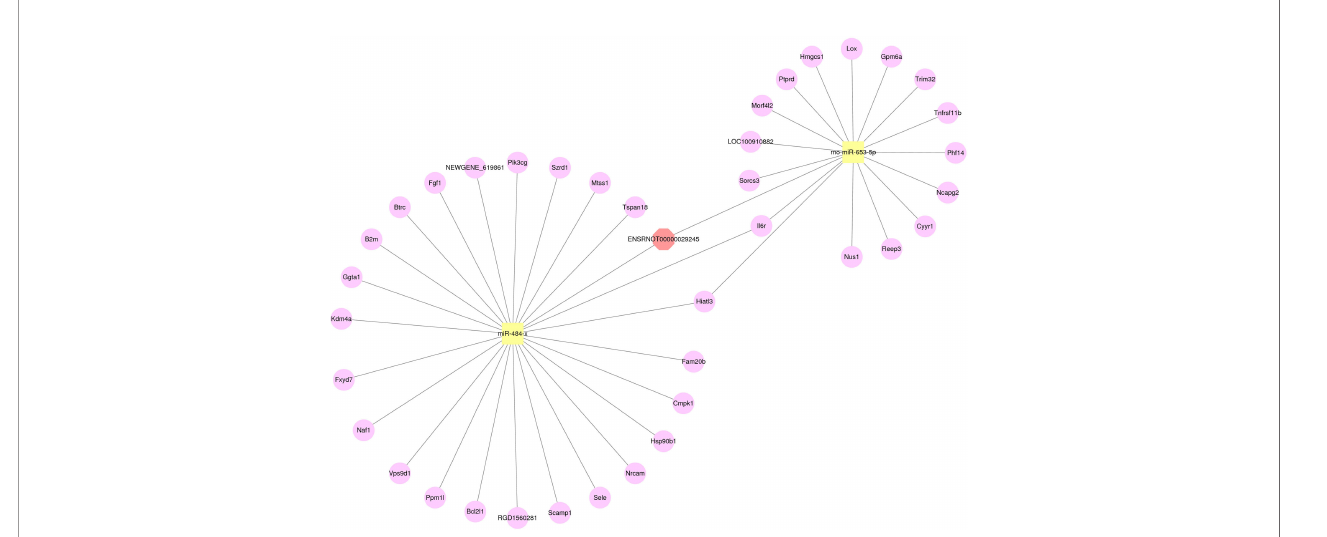
FIGURE 6 | The network of lncRNA-miRNA-mRNA. Red octagons represent up-regulated lncRNAs, yellow squares represent up-regulated miRNAs, and pink circles represent up-regulated